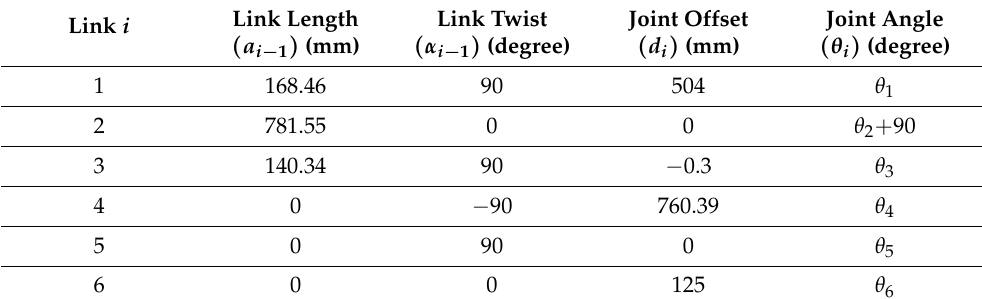
Table 4. The D-H parameters of ER20C-C10.